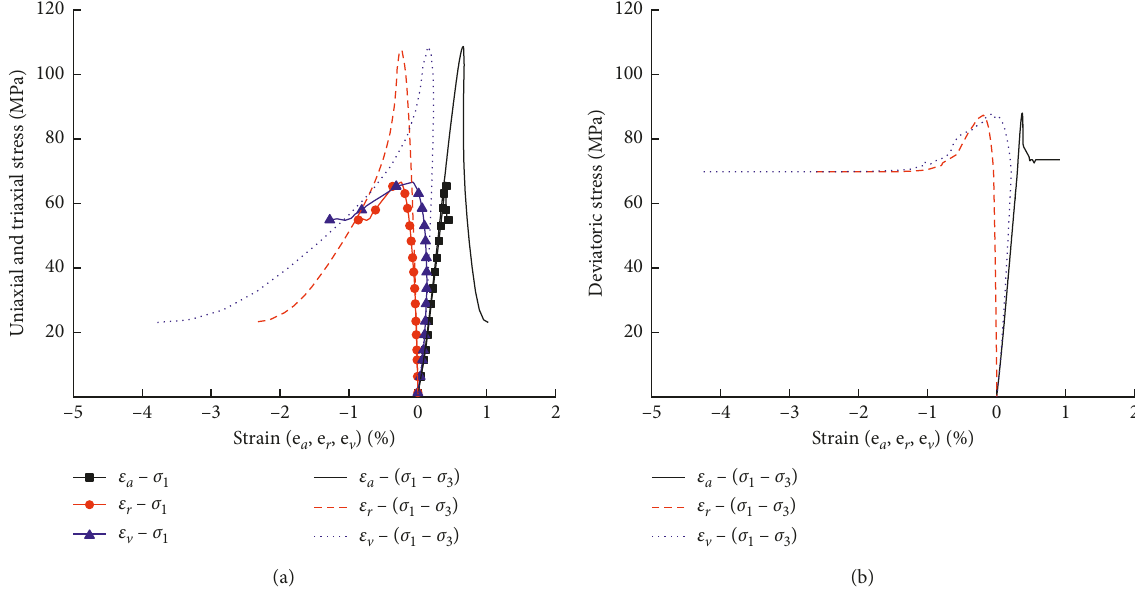
Figure 6: Stress-strain curves. (a) Stress-strain curves of uniaxial and triaxial compression tests. (b) Stress-strain curves of triaxial compression tests under unloading confining pressure condition.